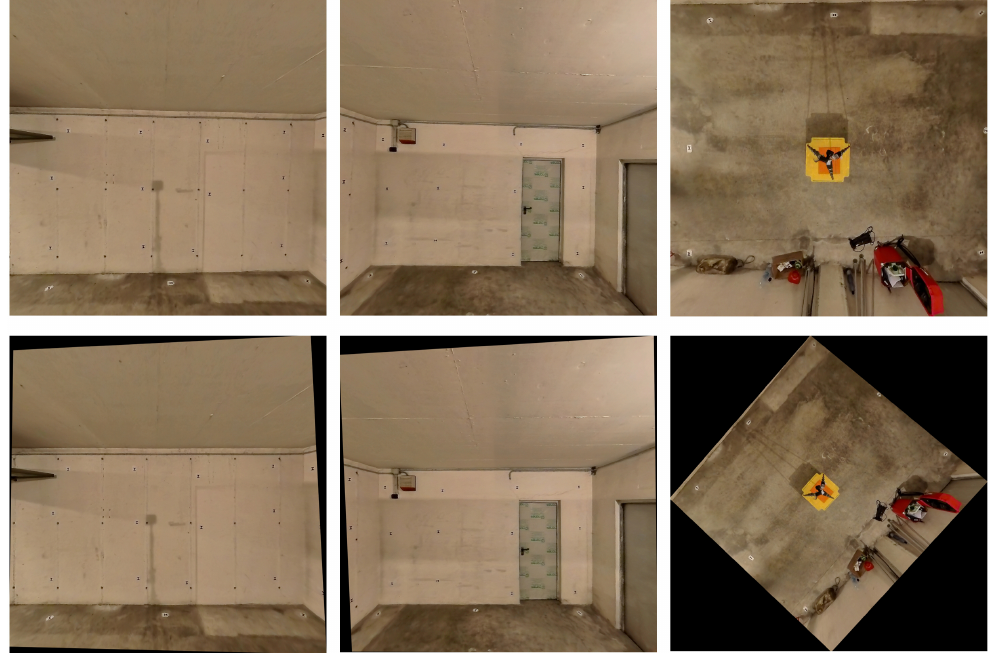
Figure 8. ( Top ): The three rectilinear images extracted from a single spherical projection; ( Bottom ): the metrically rectified